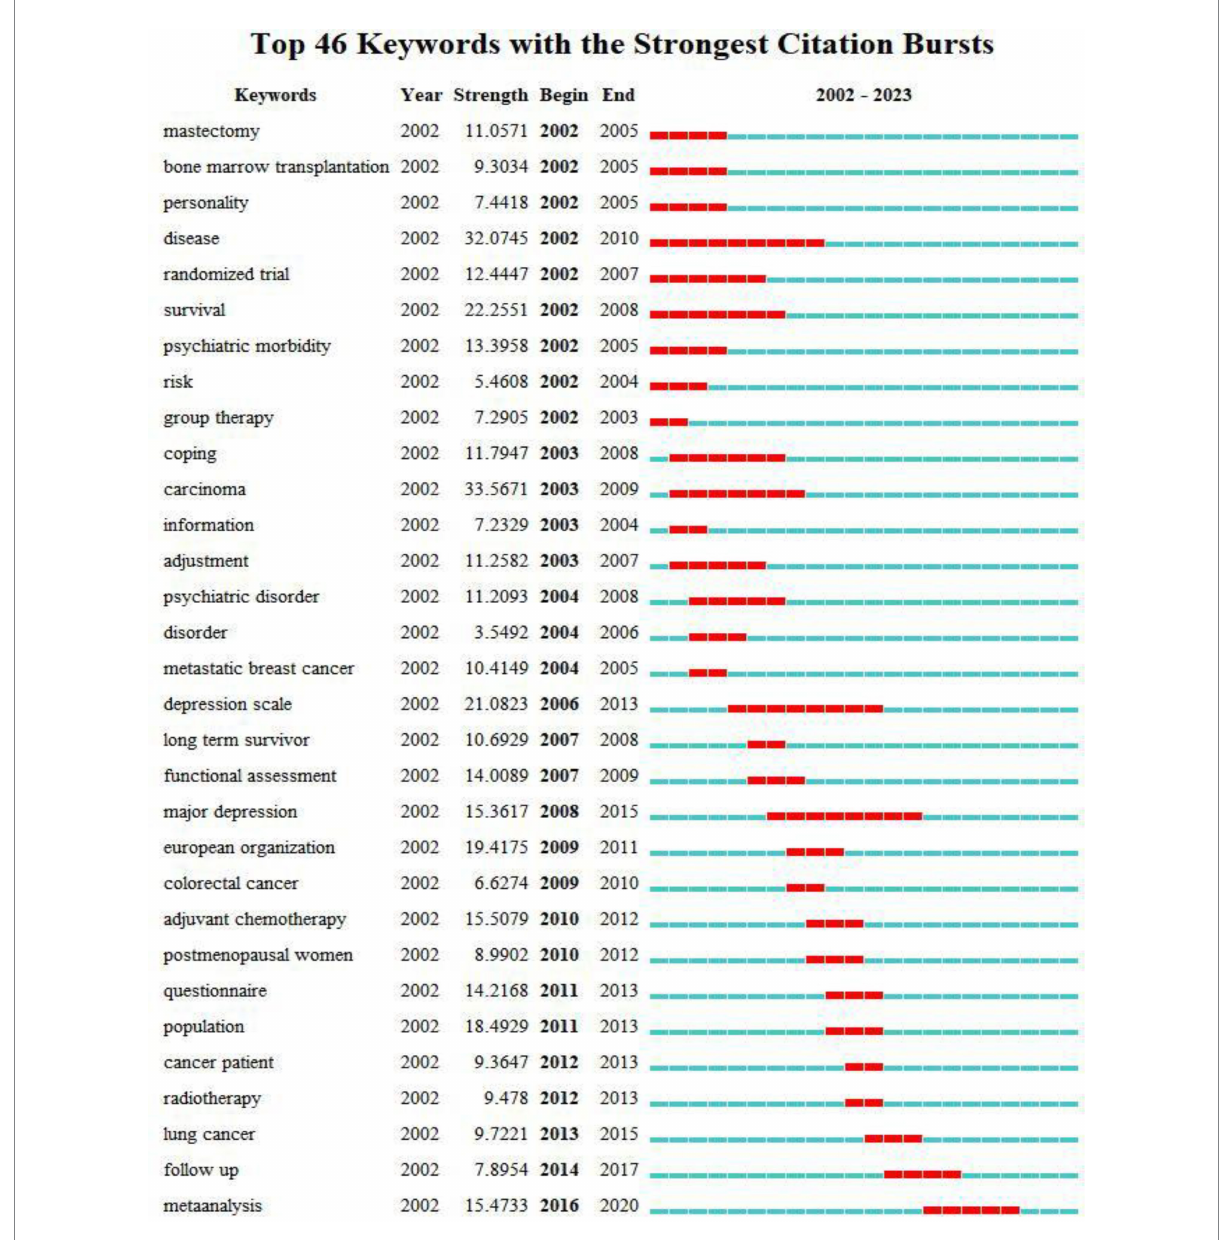
FIGURE 4 Keywords co-occurrence analysis of global research about depression in breast cancer. (A) Network visualization of the keywords; (B) Keywords co-occurrence overlay mapping from 2002 to